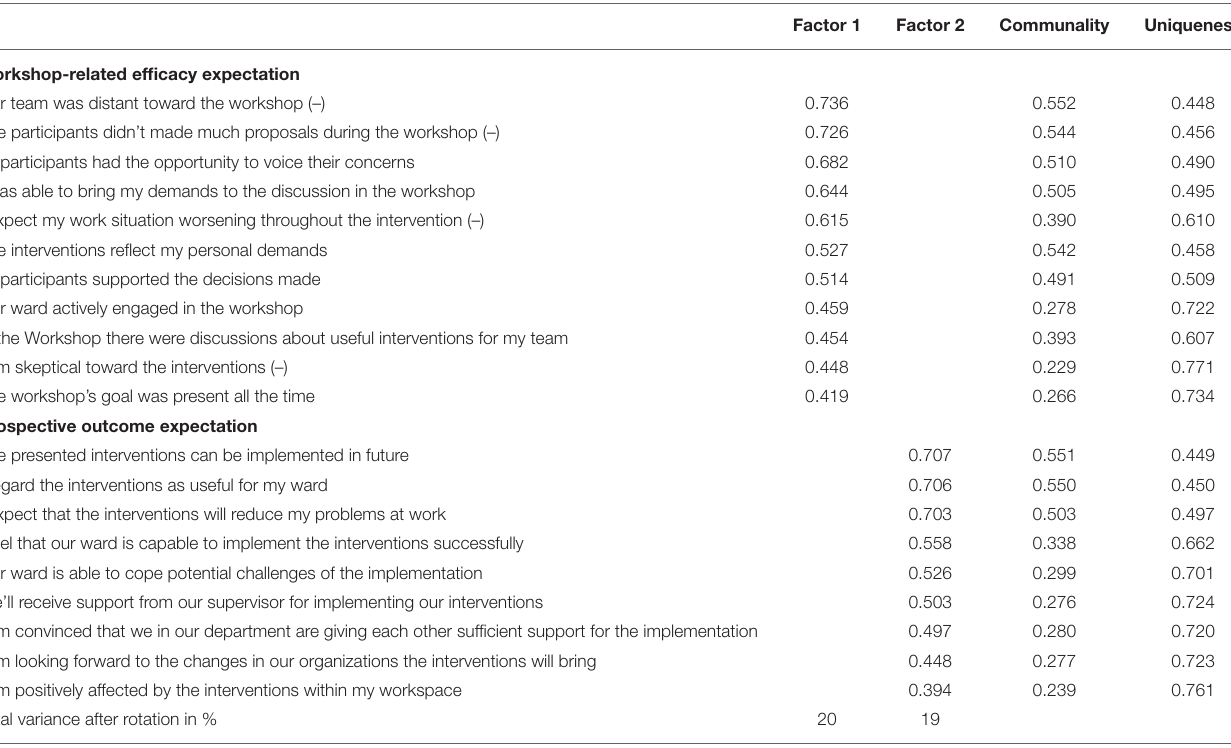
TABLE 5 | Two-factor solution for the 20 Likert-scaled items ( N = 125) after varimax rotation.